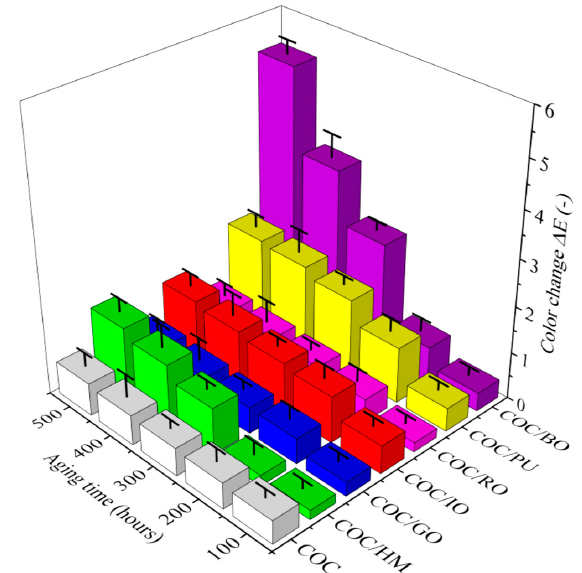
Figure 1. Color change parameter ( ∆ E) for the studied composites at di ff erent aging times.